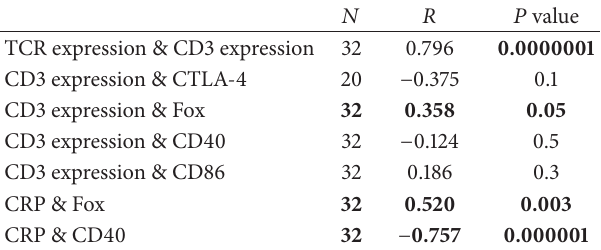
Table 4: Spearman’s correlation table with number of samples, 𝑅 , and 𝑃